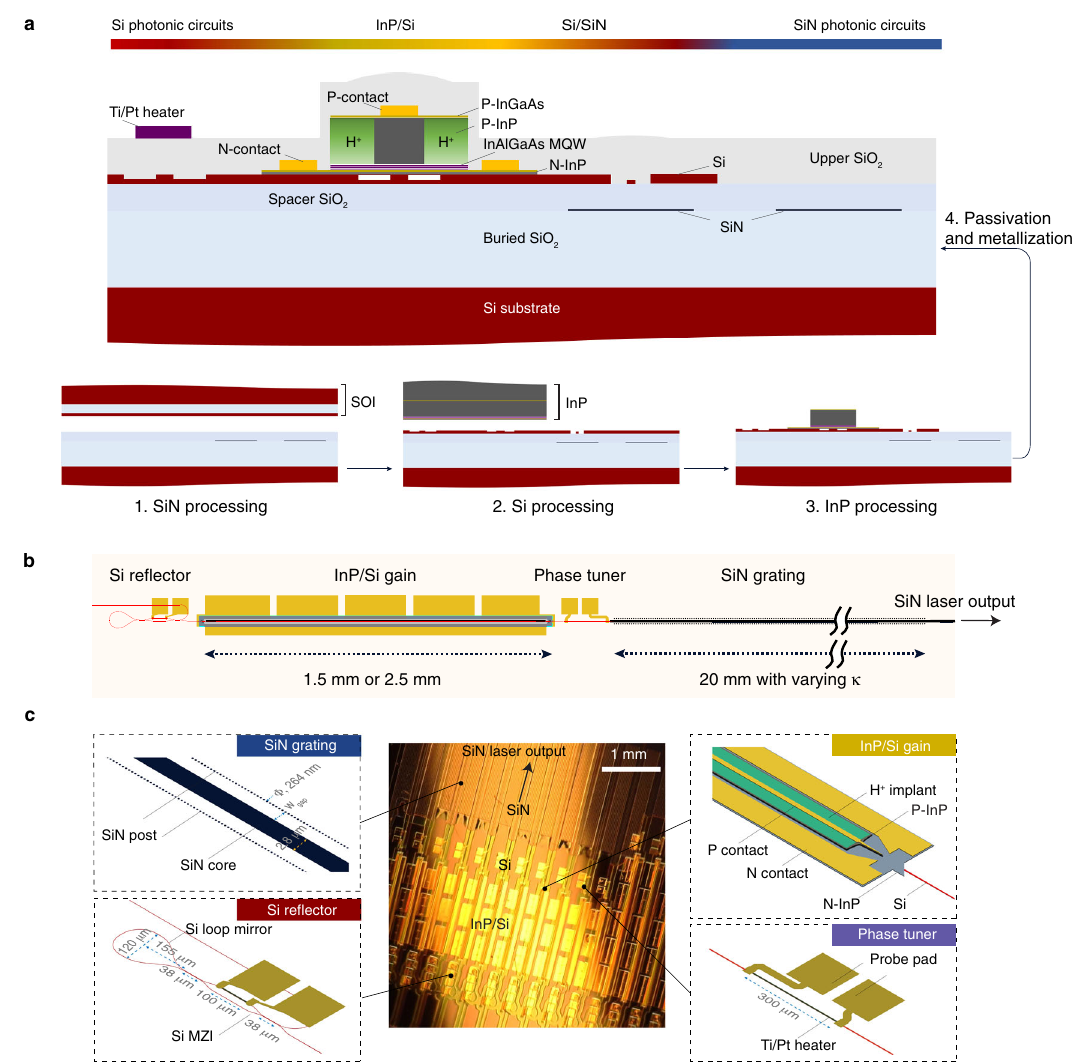
Fig. 1 Laser design and fabrication schematics. a A cross-sectional schematic illustration of the fabricated InP/Si/SiN laser integrated with Si photonic circuits and SiN photonic circuits after the laser passivation and before probe metal deposition (top). Three insets on the bottom show the fabrication process including SiN processing and SOI bonding (left), Si processing and InP bonding (middle), and InP processing (right). MQW multiple quantum well. b Top-view schematic illustration of the E-DBR laser. c A device optical photograph showing InP/Si/SiN DBR laser arrays. The lasers consist of four sections including the SiN grating, InP/Si gain section, Si re fl ector, and phase tuner, with schematics and dimensions shown,